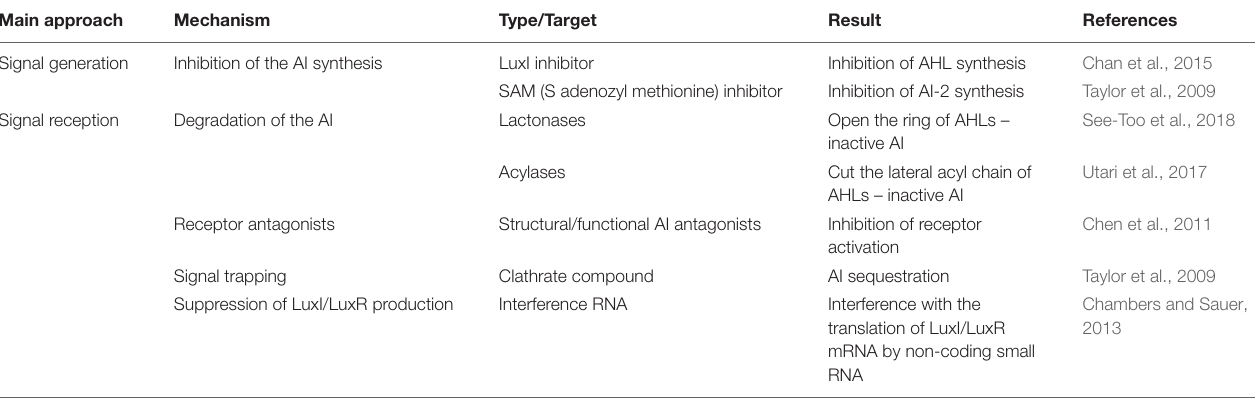
TABLE 1 | Mechanisms of quorum sensing modulation in Gram negative